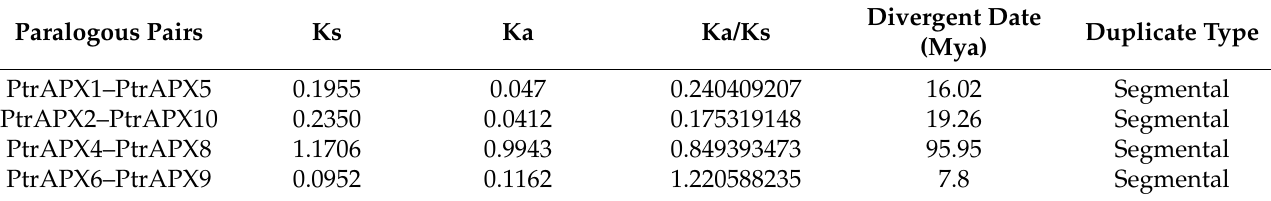
Figure 3. Chromosomal location and gene duplication of PtrAPX genes. The 11 PtrAPX genes were distributed on six chromosomes in the P. trichocarpa genome. Red dotted lines show the links between duplicated gene pairs. Scale bar = 3Mb. Table 2. Ka/Ks ratios for duplicate APX genes in P. trichocarpa